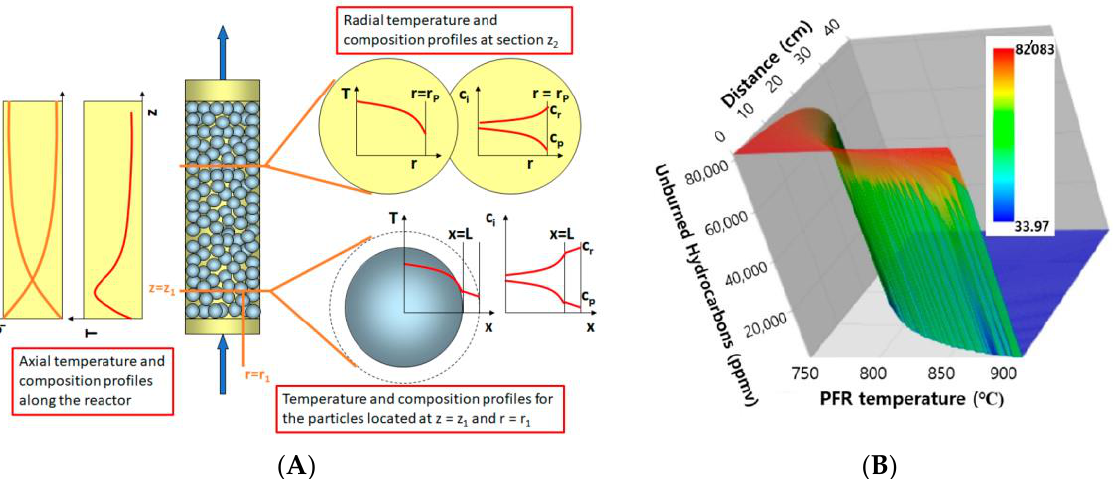
Figure 3. ( A ) Sketch concentration and temperature gradients along both the catalyst particle radius and reactor length [5]. ( B ) Unburned hydrocarbon concentration at the center of the reactor as a function of the plug flow reactor length and temperature [7].